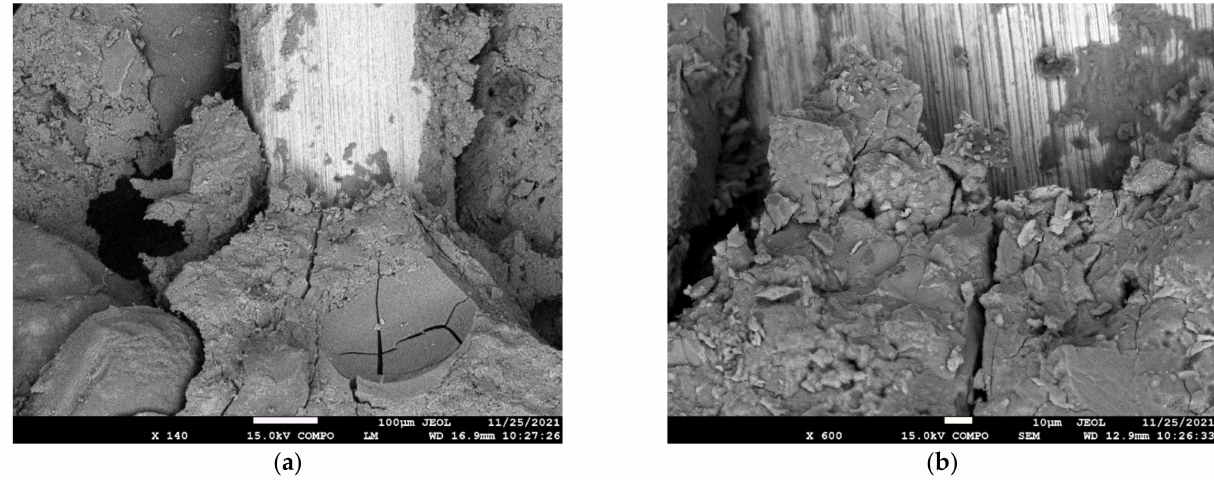
Figure 12. Microstructure ( a ) scale 140 × ( b ) scale 600 × —fiber-reinforced concrete (90 kg/m 3